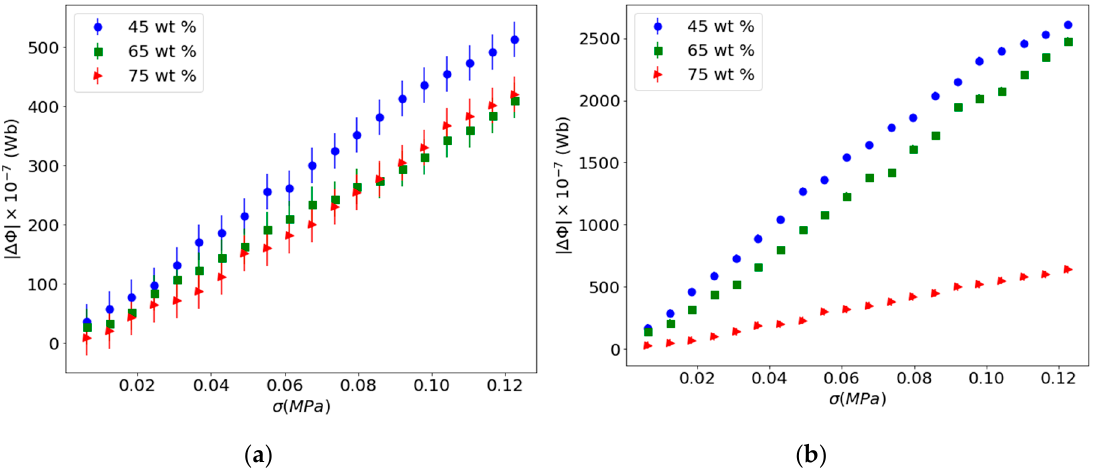
Figure 6. Villari effect in function of the filler concentration: ( a ) As-manufactured samples; ( b ) after being submitted to a magnetic field of 1 T, second and fourth steps of the procedure, respectively.